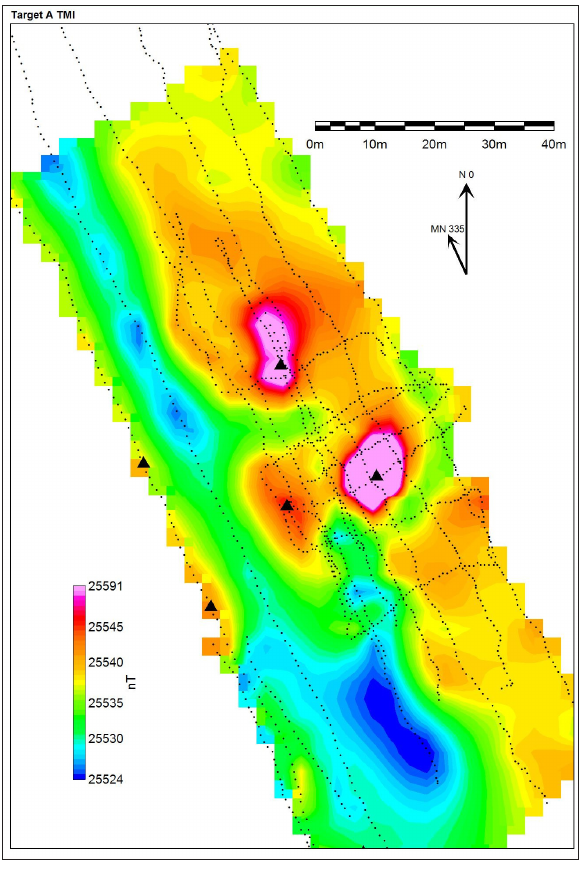
Detailed magnetic survey of the principal target area, imme- diately to the west of the Dolphin Beach